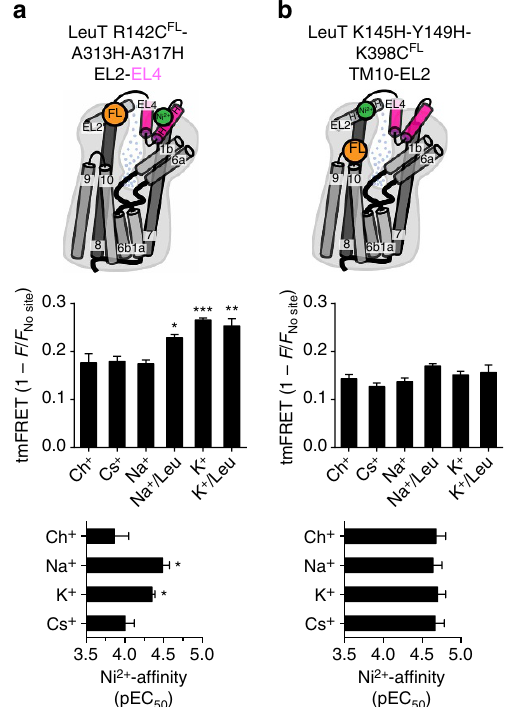
Figure 3 | Further evaluation of EL4 movements by additional tmFRET probes. ( a ) Top panel: illustrating tmFRET principle between EL2:EL4 with FL conjugated to an inserted cysteine in EL2 (orange sphere, R142C) and Ni 2 þ coordinated by His- X 3 -His motif in EL4 (green sphere, A313H- A317H). Middle panel: tmFRETresults from LeuT R142C FL -A313H-A317H in 5mM Ni 2 þ and 200mM of the indicated ion. tmFRET is significantly increased by K þ and Na þ /Leu suggesting a reduction in the mean distance between EL2 and EL4. As for the EL4:TM10 probing in Fig. 2, Na þ shows no significant change compared with Ch þ or Cs þ . The further addition of leucine (100 m M) does significantly increase tmFRET intensity. Bottom panel: Ni 2 þ affinities (pEC 50 ) derived from tmFRETexperiments on LeuT R142C FL -A313H-A317H showing higher Ni 2 þ affinity in Na þ and K þ . ( b ) Top panel: tmFRET between principle TM10 and EL2 (LeuT K145H-Y149H-K398C FL ) as in a with results (middle panel) in 5mM Ni 2 þ and 200mM of the indicated salts. tmFRET is not significantly affected by K þ , suggesting that the mean distance between TM10 and EL2 is not changed compared with application of the other indicated cations. Data points are means ± s.e.m., n ¼ 3–6. * P o 0.05; ** P o 0.01; *** P o 0.0005; denote significance level from a one-way analysis of variance with post hoc Bonferroni’s multiple comparison test relative to the Ch þ condition for the respective tmFRET